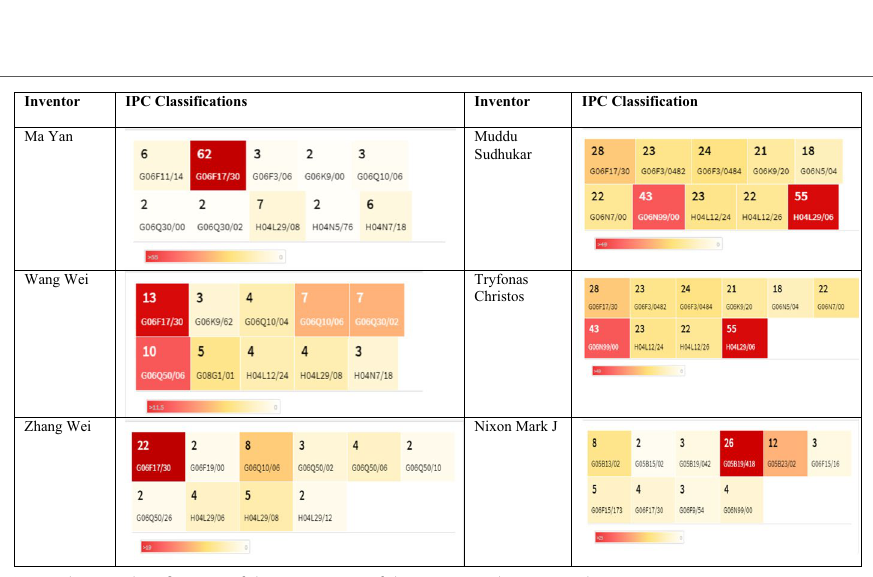
Fig. 4 The IPC classification of the inventions of the most productive